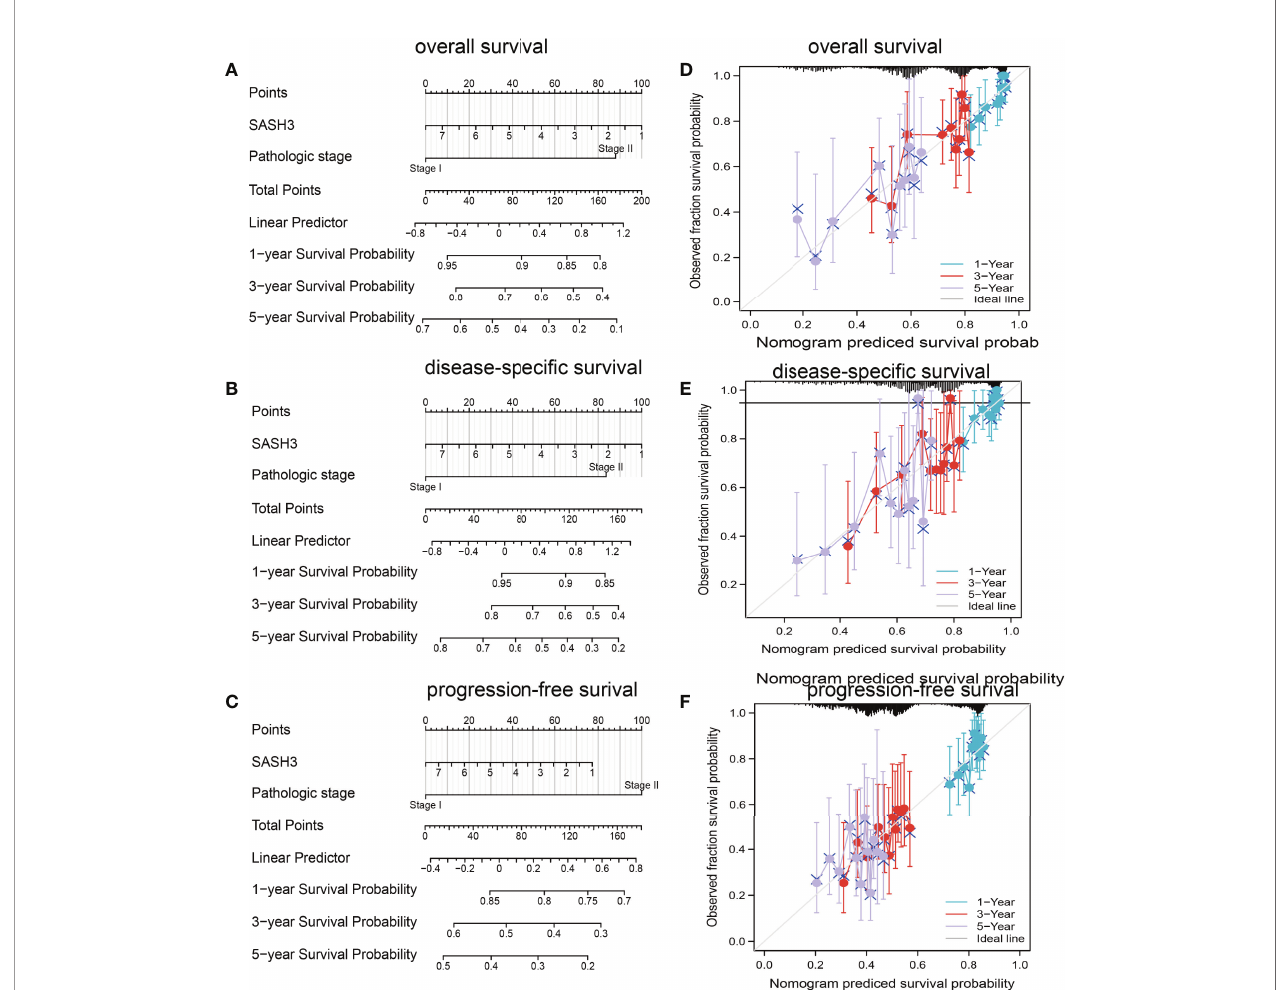
FIGURE 12 | Construction and evaluation of nomogram. Nomogram to predict (A) overall survival, (B) disease-speci fi c survival, and (C) progression-free survival of lung cancer patients. The calibration curve and Hosmer – Lemeshow test of nomograms in the TCGA-lung adenocarcinoma cohort for (D) overall survival, (E) disease- speci fi c survival, and (F) progression-free